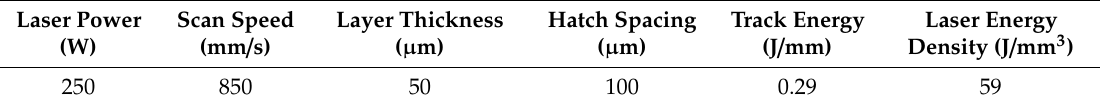
Figure 1. ( a ) Particle size distribution analyzed with laser particle sizing and ( b ) scanning electron microscopy (SEM) secondary electron image of the powder showing the particle morphology. Table 2. Optimal selective laser melting (SLM)-processing parameters determined through the production